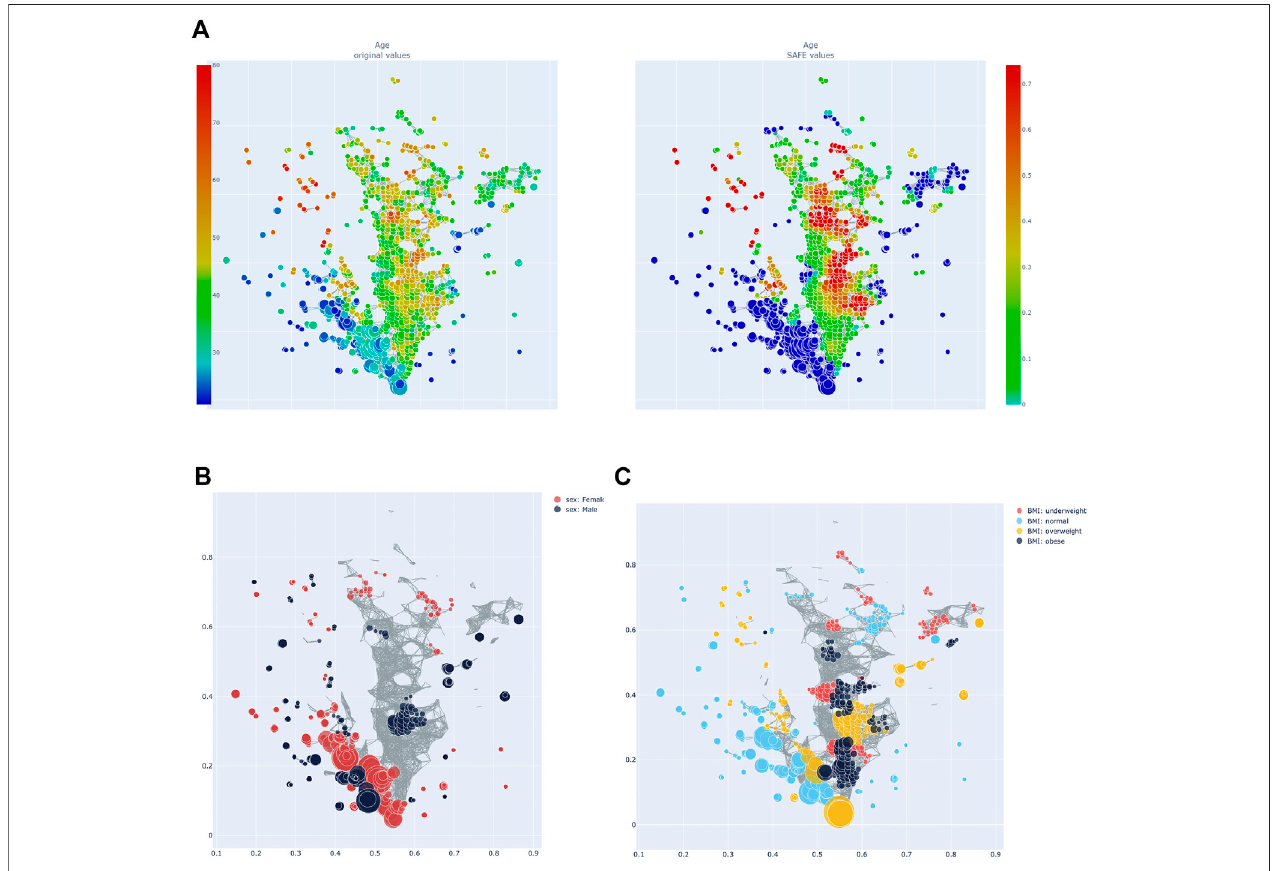
FIGURE 3 | (A) Heatmap of age: distribution of absolute value across the network on the left, enrichment on the right. (B) Network strati fi cation of sex across the network. (C) Network strati fi cation of BMI across the